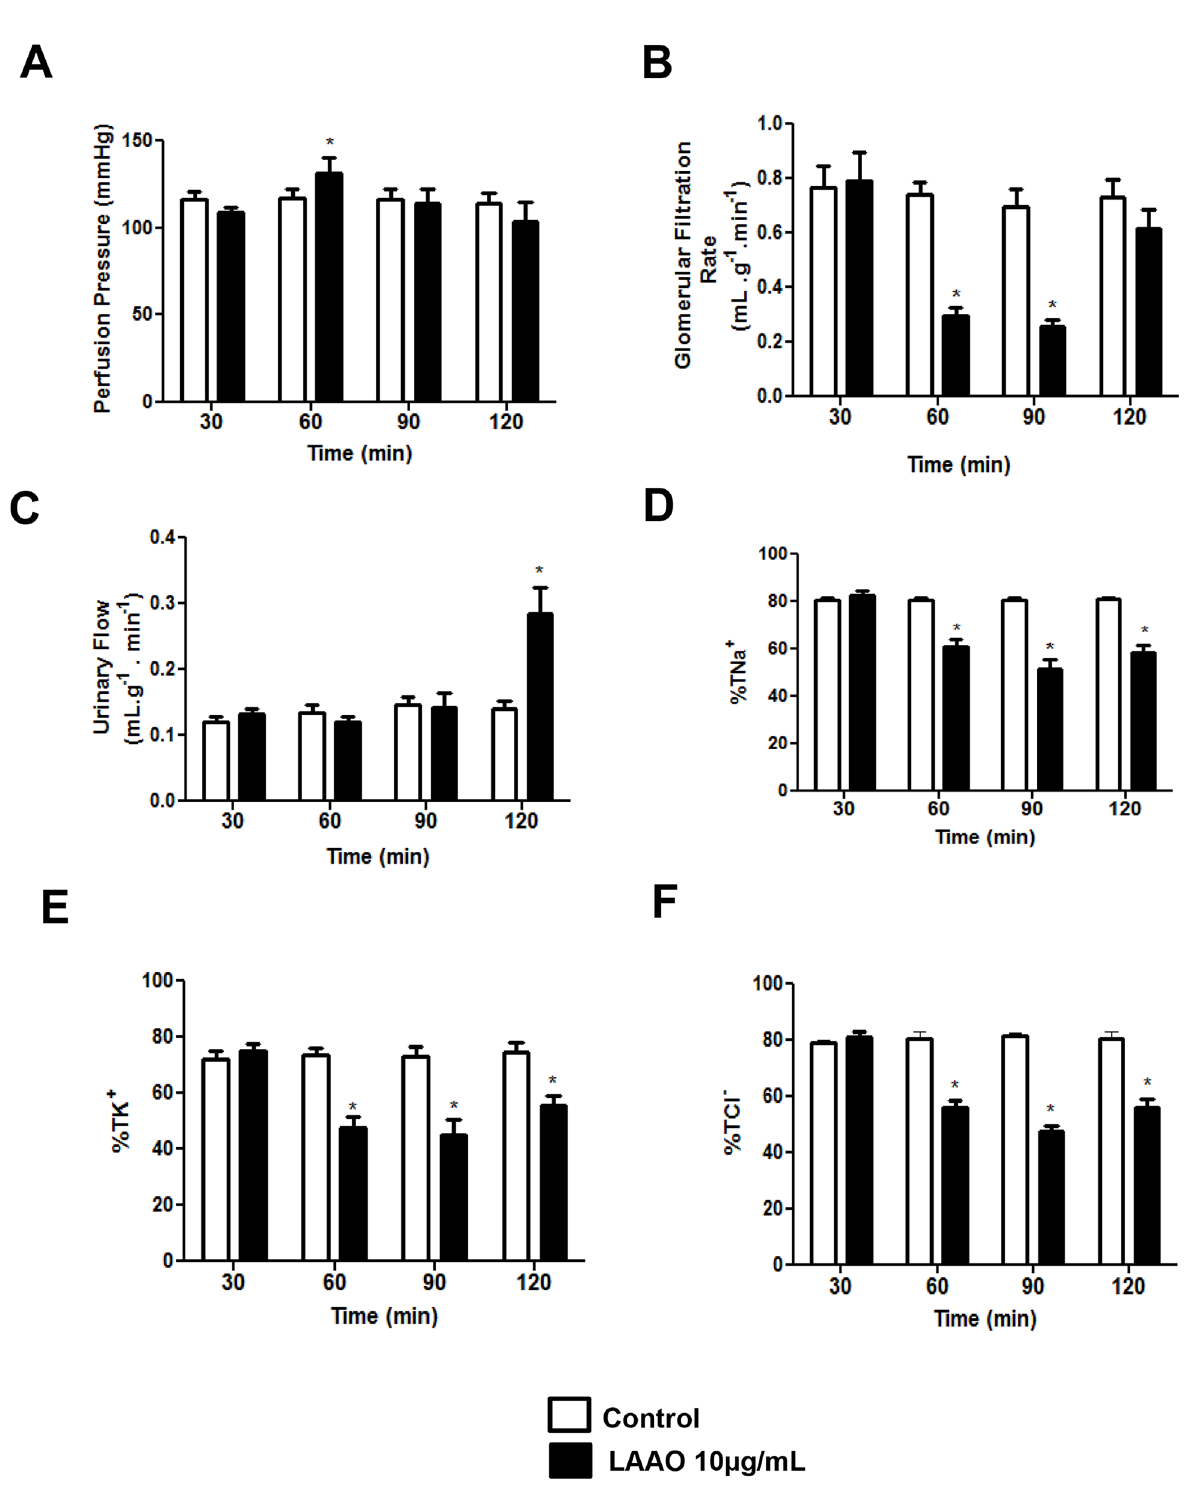
Fig 4. LAAO- Bl induced alterations in rat isolated kidney. Effects of LAAO isolated of Bothrops leucurus venom on perfusion pressure (A), glomerular filtration rate (B), urinary flow (C), sodium, potassiun and chloride (D, E, F) tubular transport percentage. LAAO- Bl was added to the system 30 min after the beginning of each perfusion. The data represent the mean ± S.E.M of at least six independent experiments. * Significantly different from control group (p < 0.05, one way ANOVA, Bonferroni post-test).